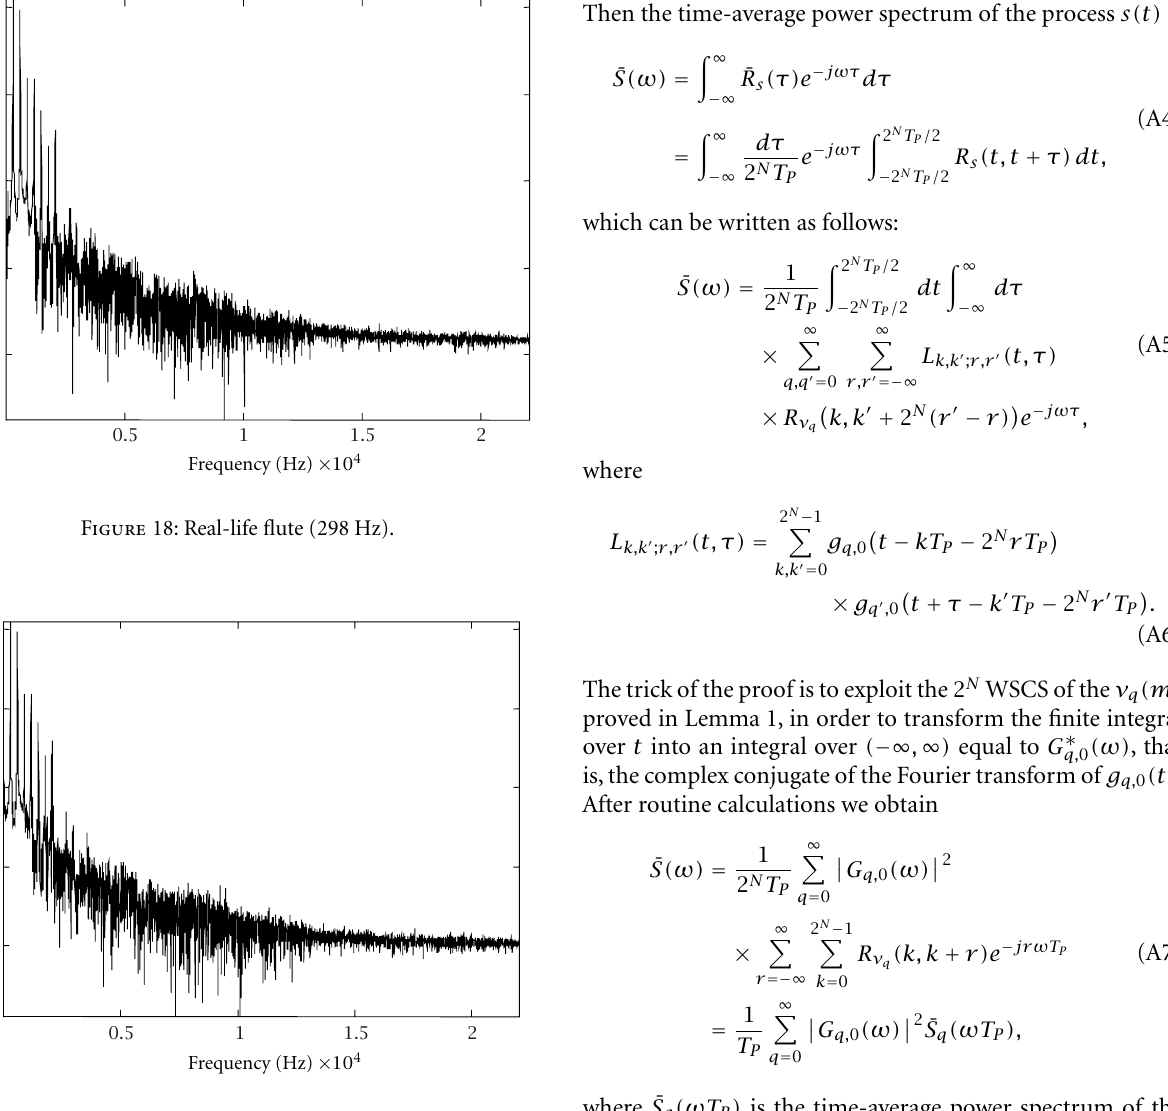
Figure 19: Synthesized flute (298